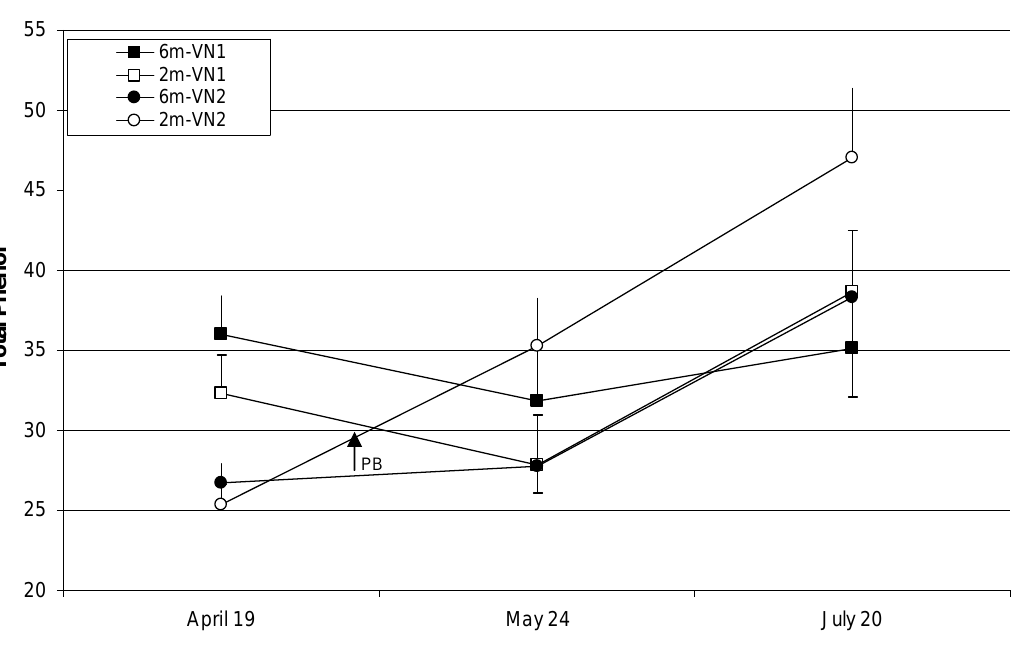
Figure 1. Total phenolic compounds contents (mg of gallic acid/g dry weight ± standard error) in needles of Pinus laricio in Valdu-Niellu forest, before and after (1 and 3 months) a prescribed burning (PB) at an unburned station (VN1) and a burned station (VN2), at 2 m and 6 m